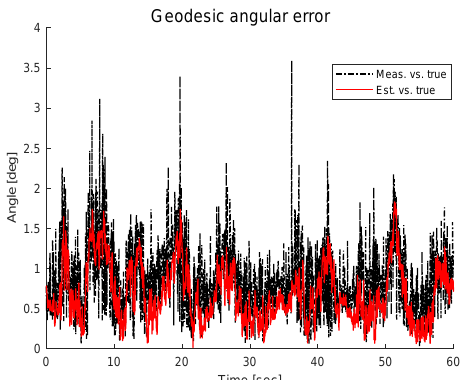
Figure 11: The black plot is the same as in Figure 9, while the red plot is the estimated error an- gle when the gyroscopes are used in addition to the camera data.